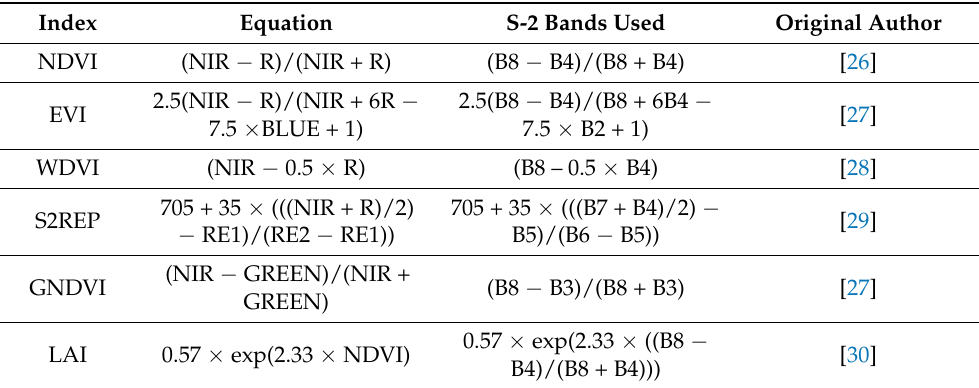
Table 2. Remote sensing indices calculated from Sentinel-2